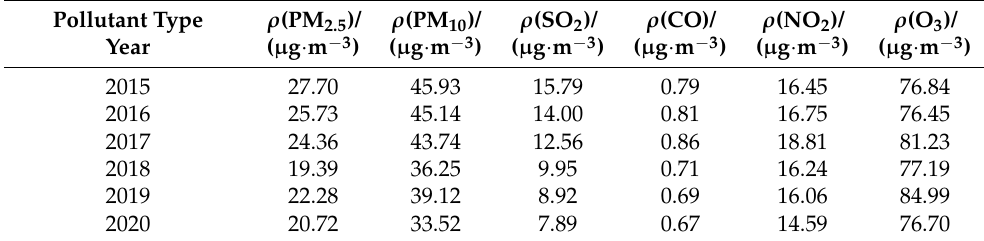
Table 1. The average concentration of major air pollutants from 2015 to 2020.